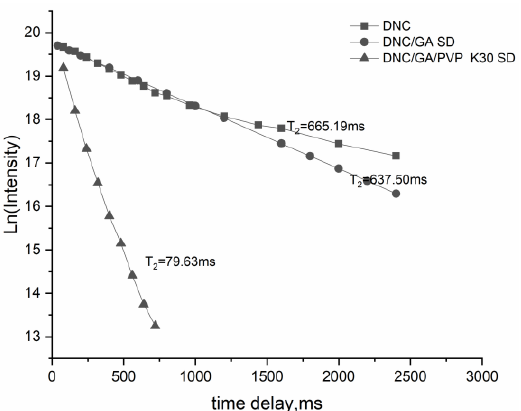
Figure 9. The relaxation time of DNC, DNC/GA SD, and DNC/GA/PVP K30 SD.